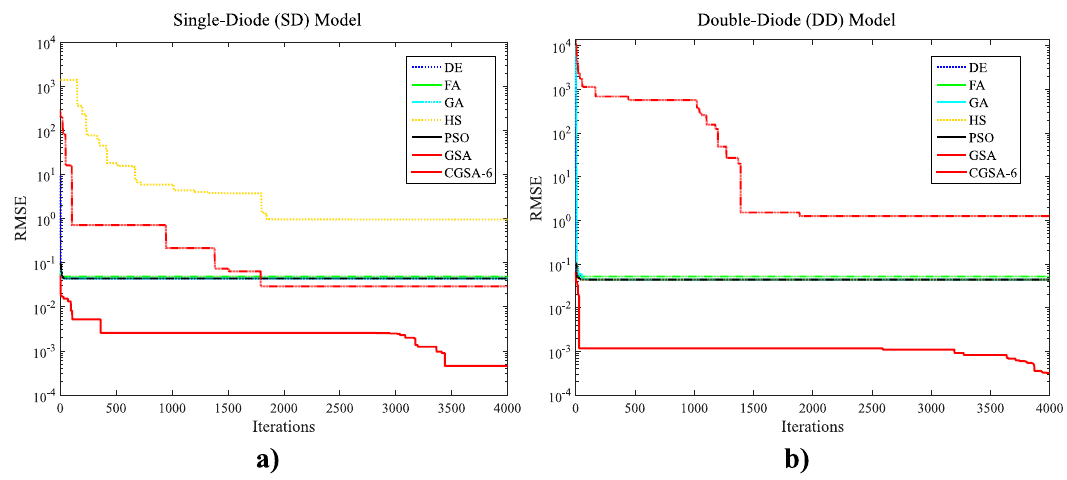
Figure 14. Evolution curves for ( a ) SD Model and ( b ) DD Model, obtained by applying DE, FA, GA, HS, PSO, GSA and CGSA-6. Table 11. PV cell parameters for the SD model, extracted by applying CGSA-6, DE, FA, GA, HS, PSO and GSA. Note that best RMSE value from among the applied methods is boldfaced.